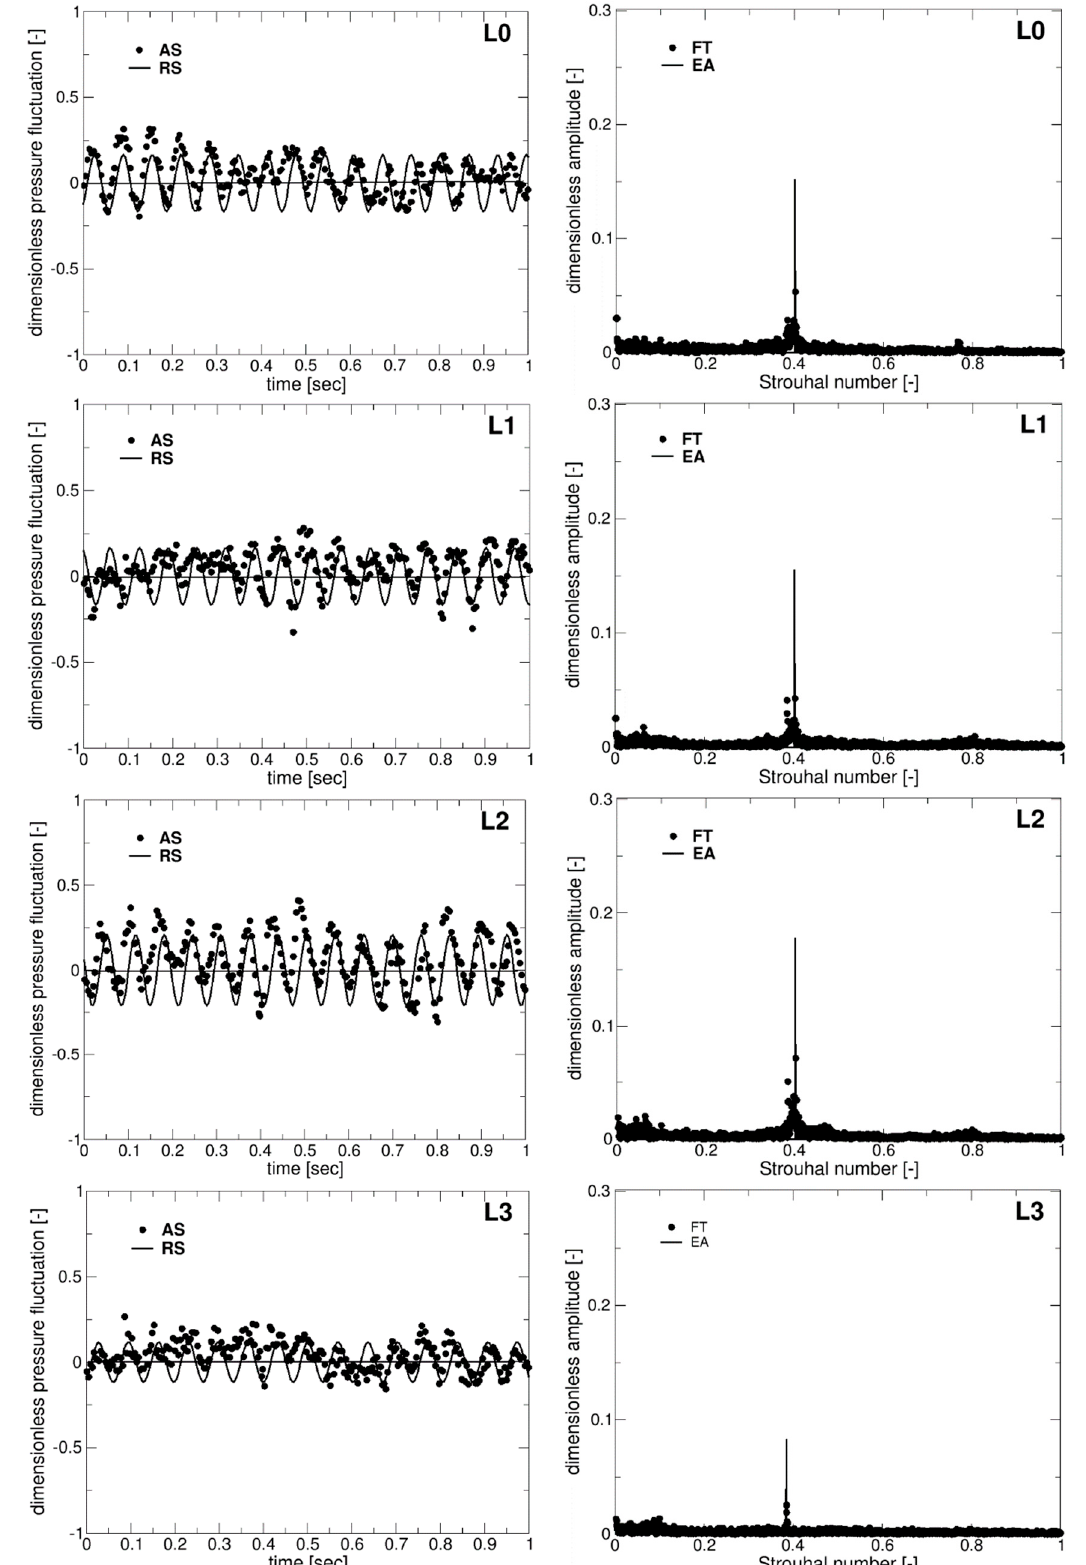
Figure 5. Pressure fluctuations on all levels with shutter area ratio of 50% (d = 0.113 m): acquired signals (AS) vs. reconstructed signals (RS) (left) and its Fourier spectra (FT) vs. equivalent amplitudes (EA) (right).